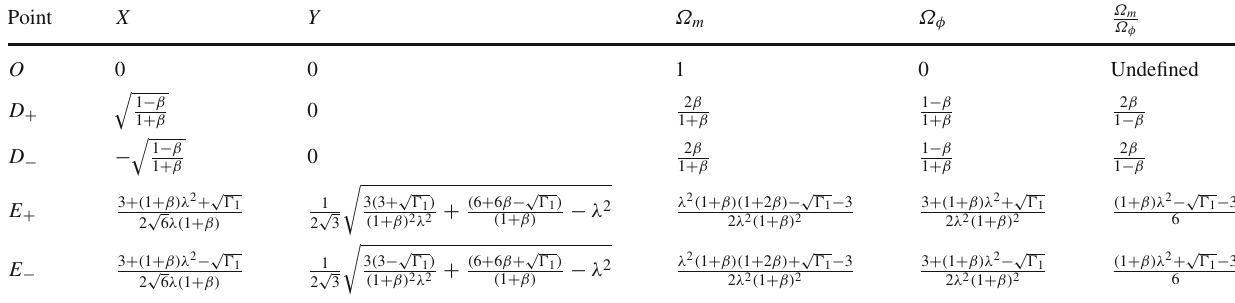
Table 3 The physically meaningful critical points of the autonomous system for the case α = 0 Point Existence Stability Saddle for all λ and − 1 < β < 1